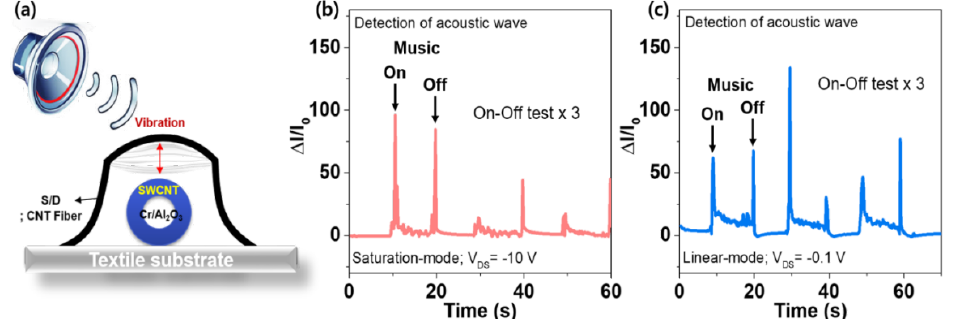
Figure 5. ( a ) Schematic illustration of sensor device’s configuration for the detection of an acoustic wave. The relative changes in the I DS of the FTPS while the music sound repeatedly turned on and off at ( b ) V DS = −10 V and ( c ) −0.1V.